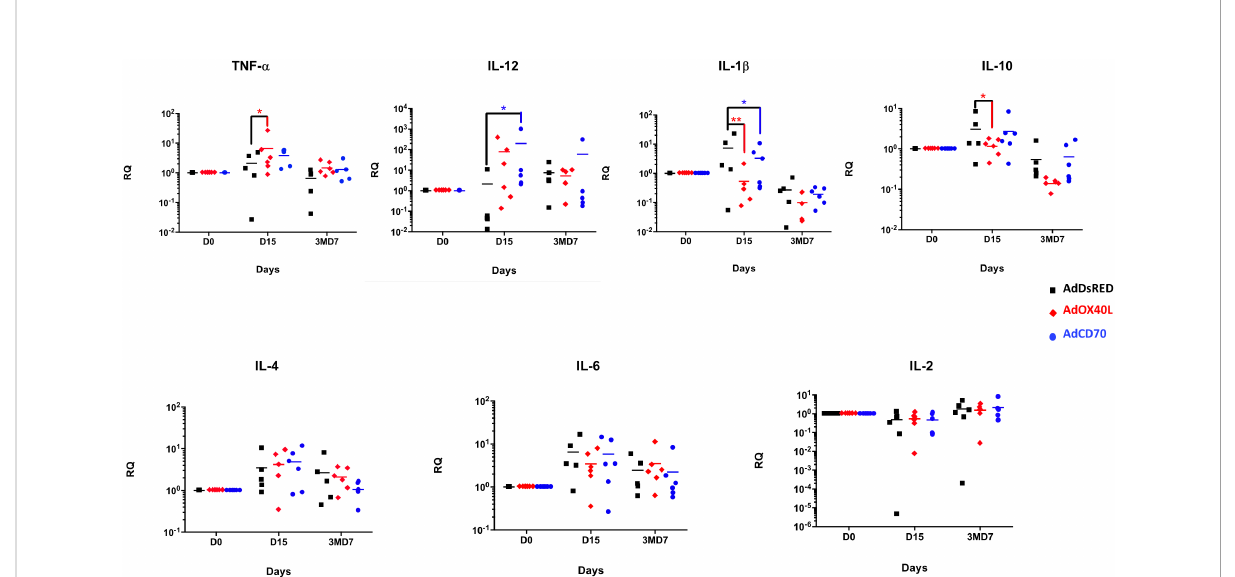
FIGURE 7 Analysis of expression of cytokine genes by qRT-PCR in sheep PBMCs. Cytokine gene expression from total RNA isolated from PBMCs obtained at days D15 and 3MD7 from the three sheep groups was measured by quantitative real-time PCR (qRT-PCR). Each individual sample was analyzed in duplicate. Relative levels of expression of cytokine mRNA were determined by comparative threshold cycle ( CT ) analysis, utilizing b - actin mRNA expression (internal control) as a reference. Statistical analysis was performed by two-way ANOVA test: *p < 0.05. Relative RNA quantity (RQ) = 2 - DD CT